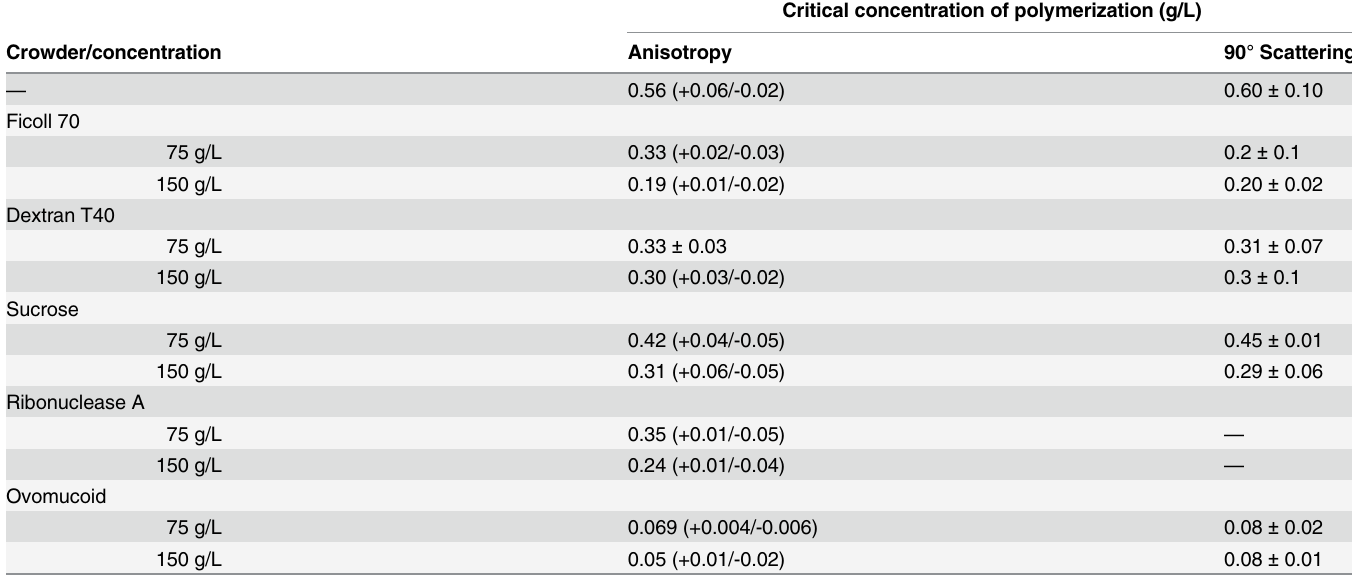
Table 1. Critical concentration of polymerization of FtsZ in the absence and presence of different